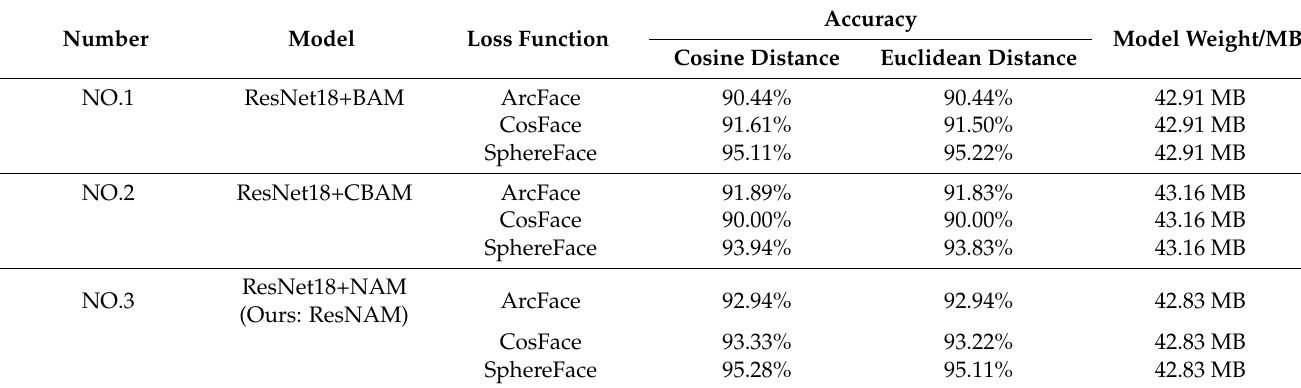
Table 5. Pig face recognition results with different attention